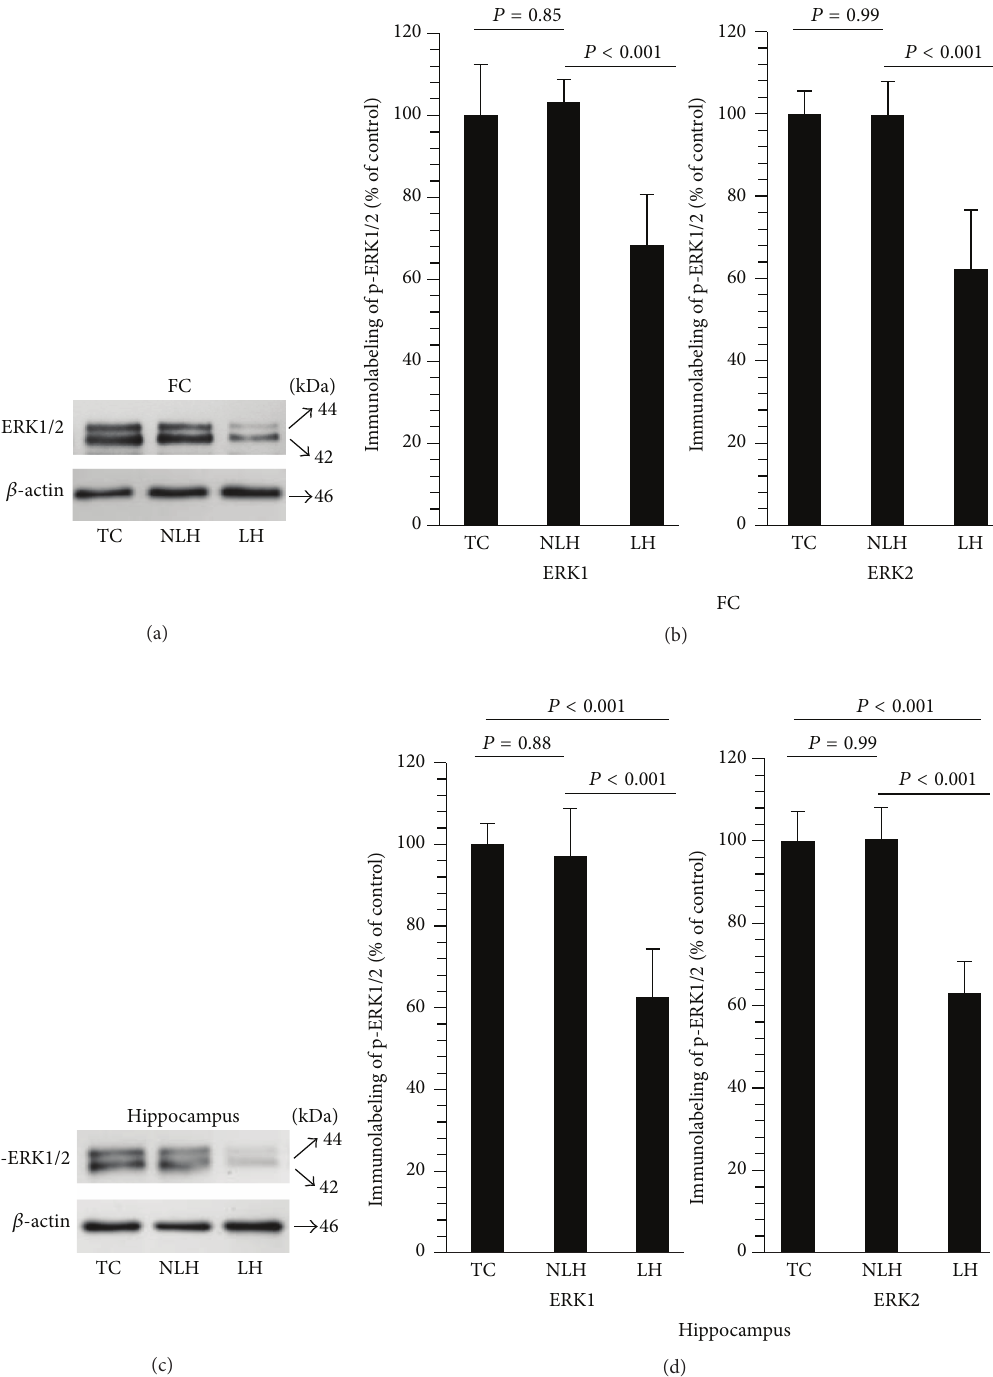
Figure 6: Immunolabeling of p-ERK1/2 in FC (a) and hippocampus (c) obtained from tested control (TC), non-learned helpless (non- LH), and learned helpless (LH) rats. 𝛽 -actin was used as endogenous control. Mean ± SD of ERK1 and ERK2 phosphorylation in FC and hippocampus of TC, non-LH, and LH rats ( 𝑛 = 6 /group) is depicted in (b) and (d), respectively. Overall group differences in the 3 groups are as follows. FC: ERK1, df = 2,15 , 𝐹 = 19.93 , and 𝑃 < 0.001 ; ERK2, df = 2, 15 , 𝐹 = 28.04 , and 𝑃 < 0.001 . Hippocampus: ERK1, df = 2,15 , 𝐹 = 26.12 , and 𝑃 < 0.001 ; ERK2, df = 2, 15 , 𝐹 = 48.89 , and 𝑃 < 0.001